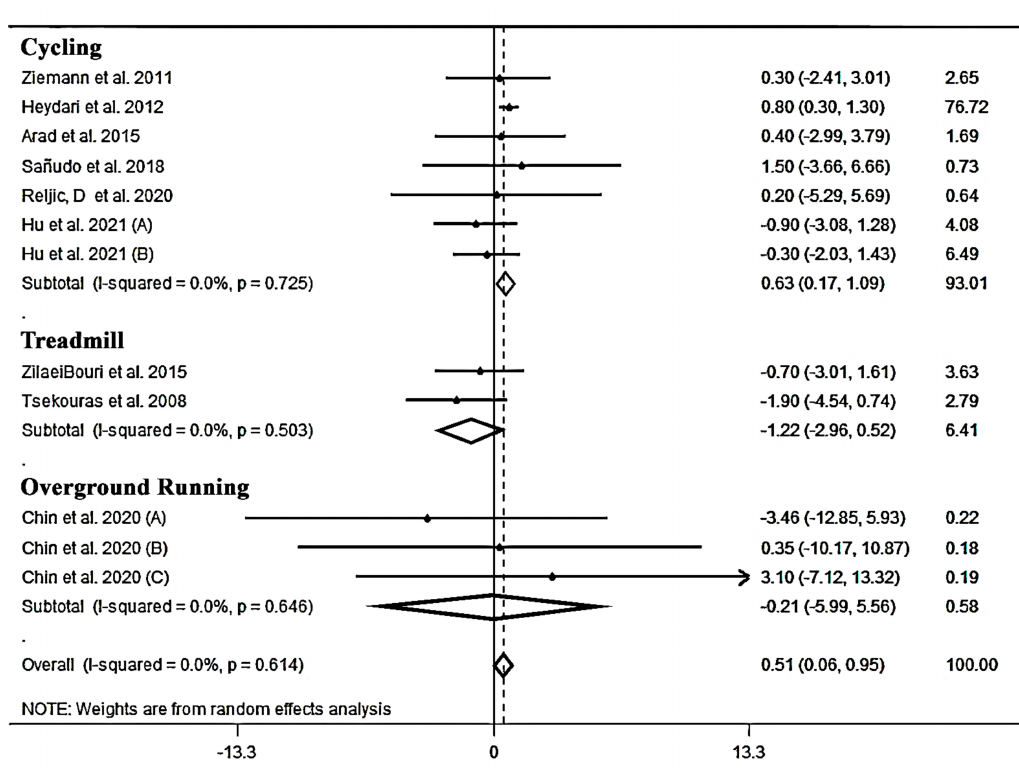
Figure 4. Forest plot detailing weighted mean difference and 95% confidence intervals (CIs) for the effect of high-intensity interval training on